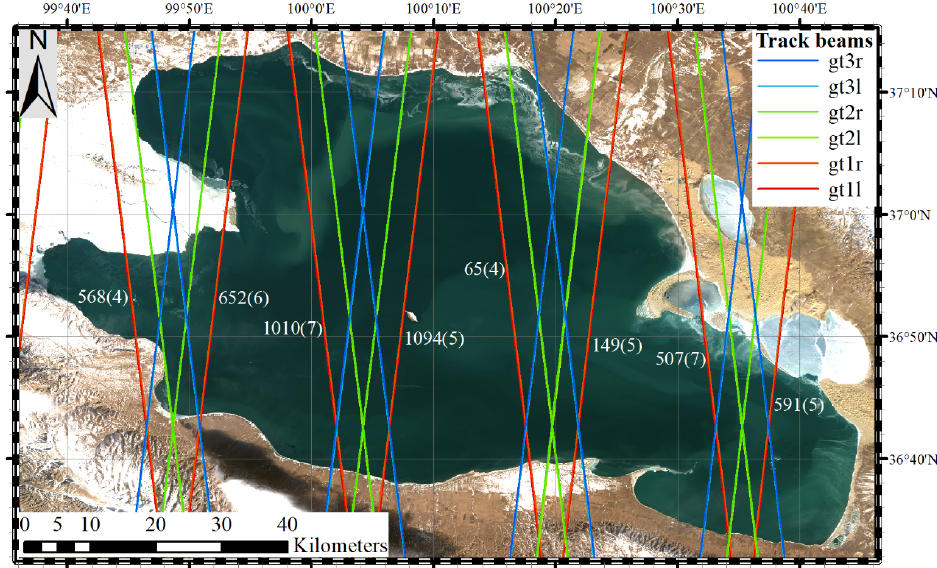
Figure 4. The track beams of the ICESat-2 overpass of Qinghai Lake (note: Landsat 8 Operational Land Imager (OLI) from 10 December 2018). Table 4. Track IDs and the corresponding available days of ICESat-2 data covering Qinghai Lake. Track